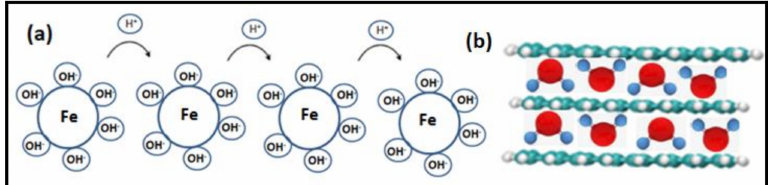
Figure 2. Sensing of soil moisture ( a ) chemical bond or ( b ) interchelation across